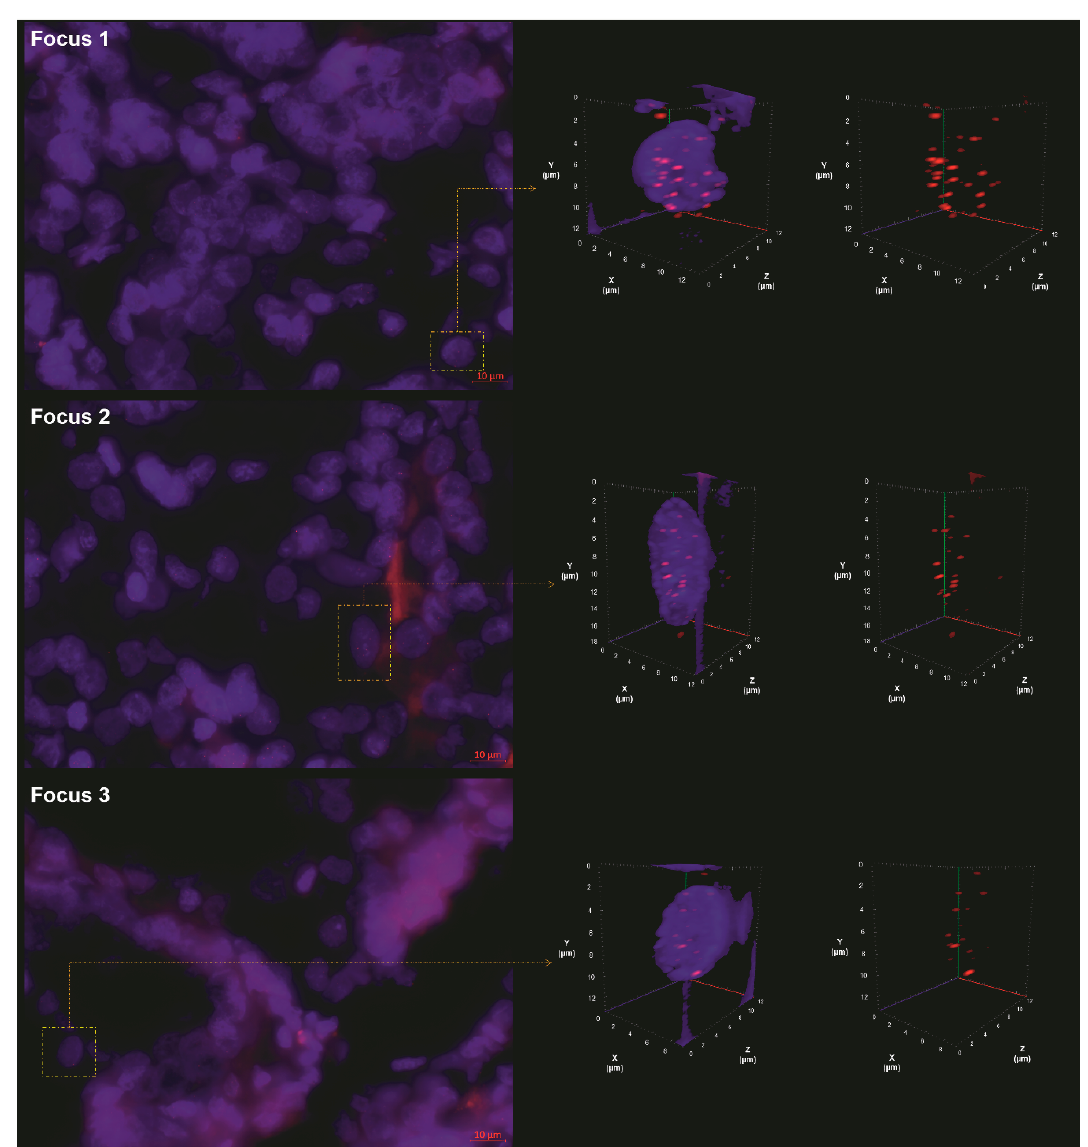
Figure 1. Images from the quantitative fluorescence in situ hybridization (Q-FISH) of the three foci, showing the 2D raw image ( left panel ) and the 3D deconvolved nuclei ( right panel ). The right panel shows the representative 3D nuclear telomere distribution (red signals) with and without the counterstained nucleus (blue). In this figure, we can observe the progressive change of 3D telomere nuclear architecture from focus 1 to focus 3.